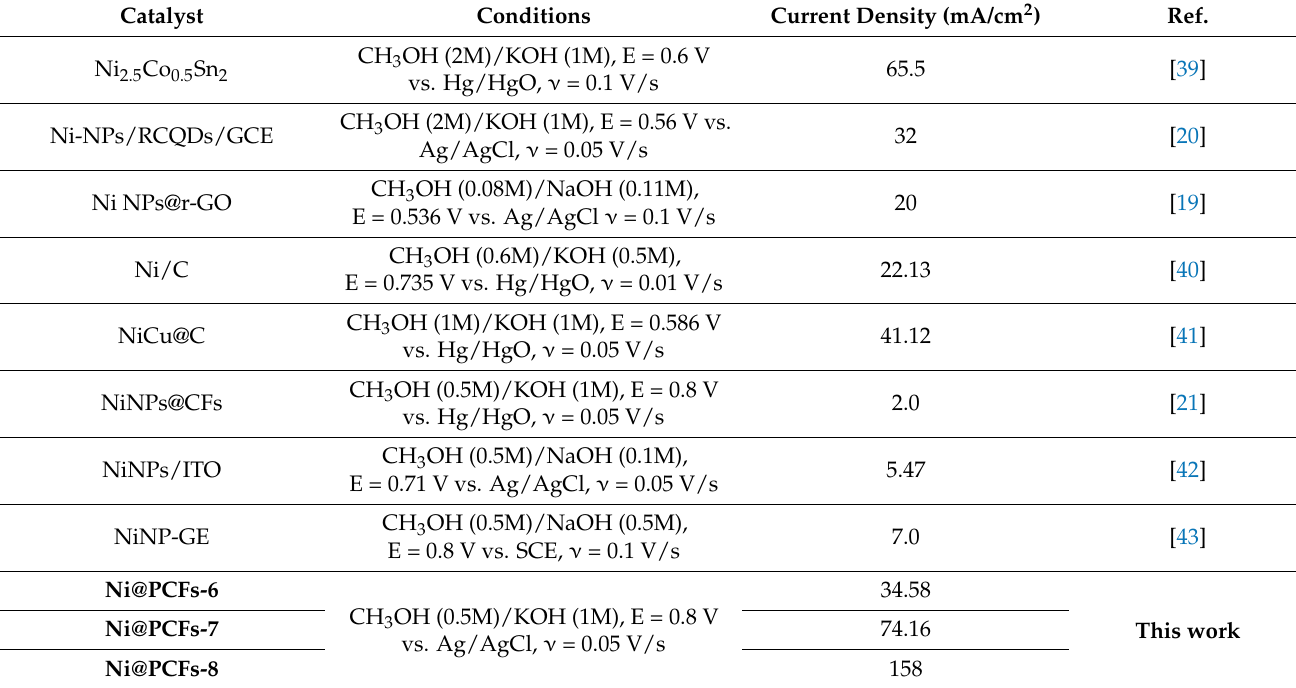
Table 2. Comparison of the current density of differnt nickel-based catalysts supported on carbon